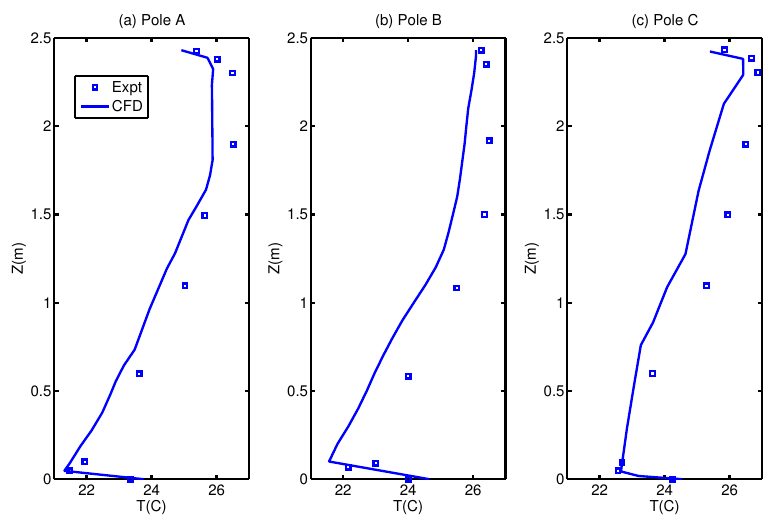
Figure 5. Temperature comparisons between the CFD results and experimental data at: ( a ) Pole A; ( b ) Pole B; and ( c ) Pole C.